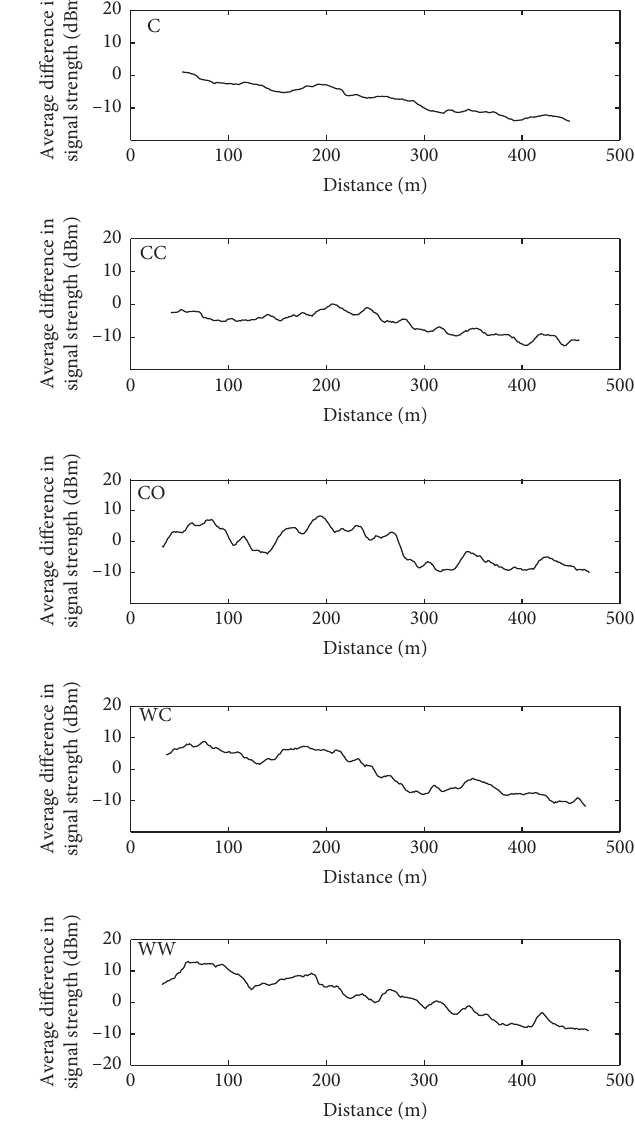
Figure 6: Average difference between the vertically polarized and the horizontally polarized field